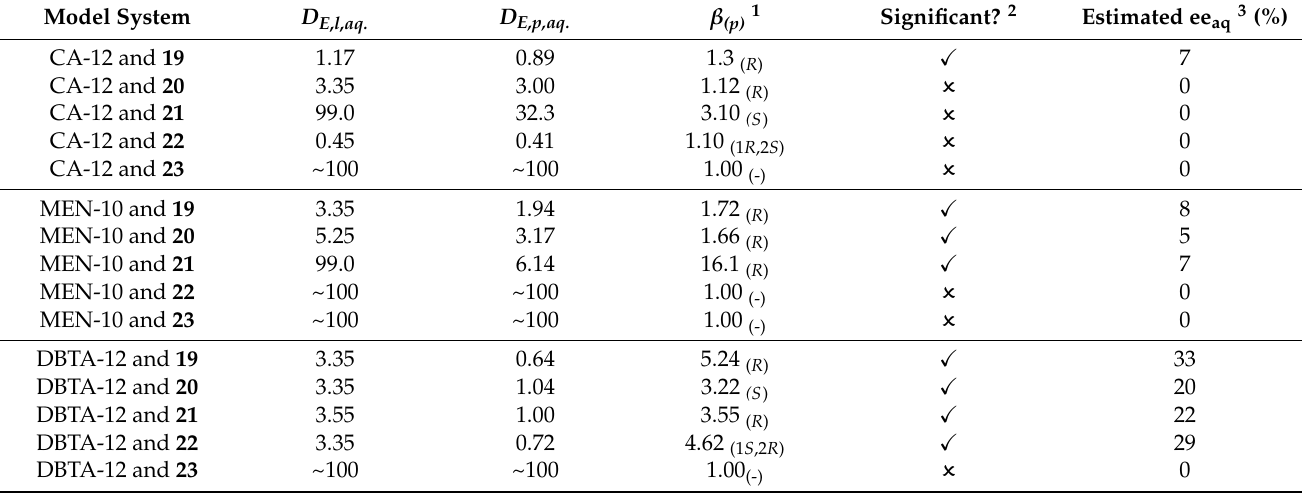
Table 2. Separability studies on the isolated, single enantiomers of the model compounds 19 – 23 using model systems containing CA-12, MEN-10 or DBTA-12 selector molecules (incubation = 60 min).